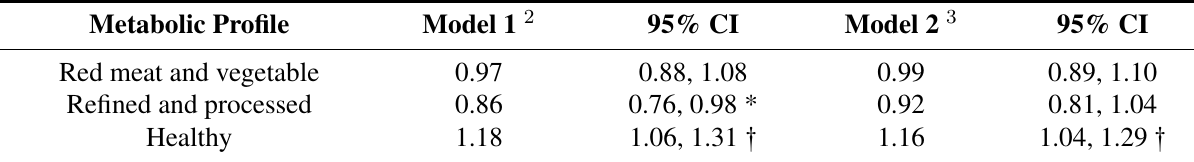
Table 3. Odds ratios (95% confidence interval (CI)) for metabolic profile 1 , according to dietary pattern.